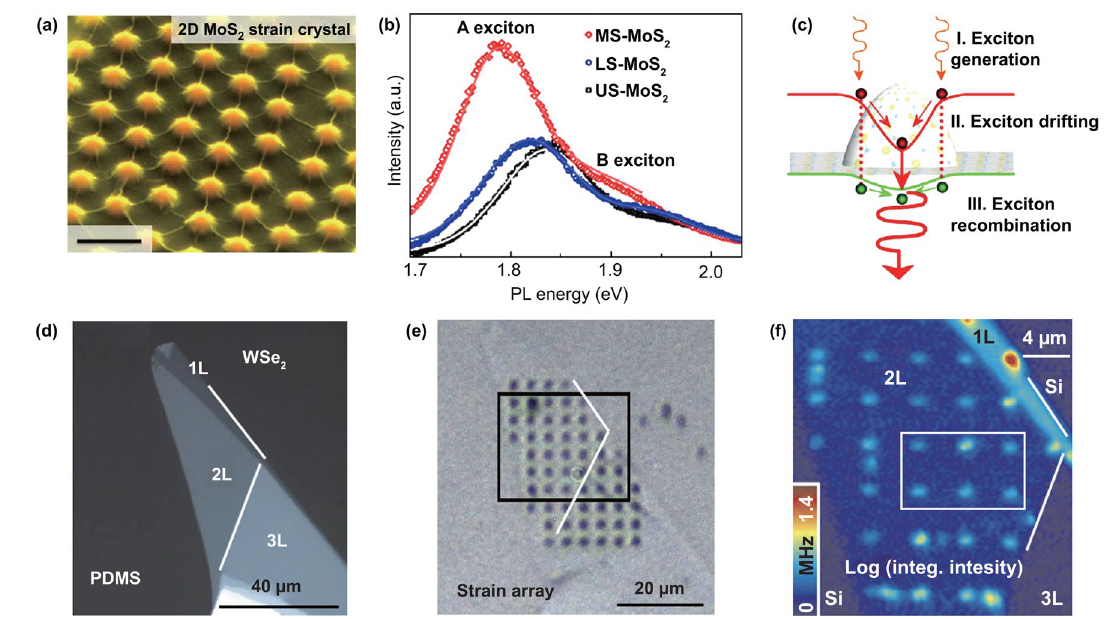
Fig. 10 Applied biaxial strain by transfer 2D materials to patterned substrates. a SEM image of the 2D MoS 2 transferred onto a nanocone array substrate; scale bar is 100 nm. b PL spectra of most strained, less strained and unstrained 2D MoS 2 . c Schematic of the funnel effect in